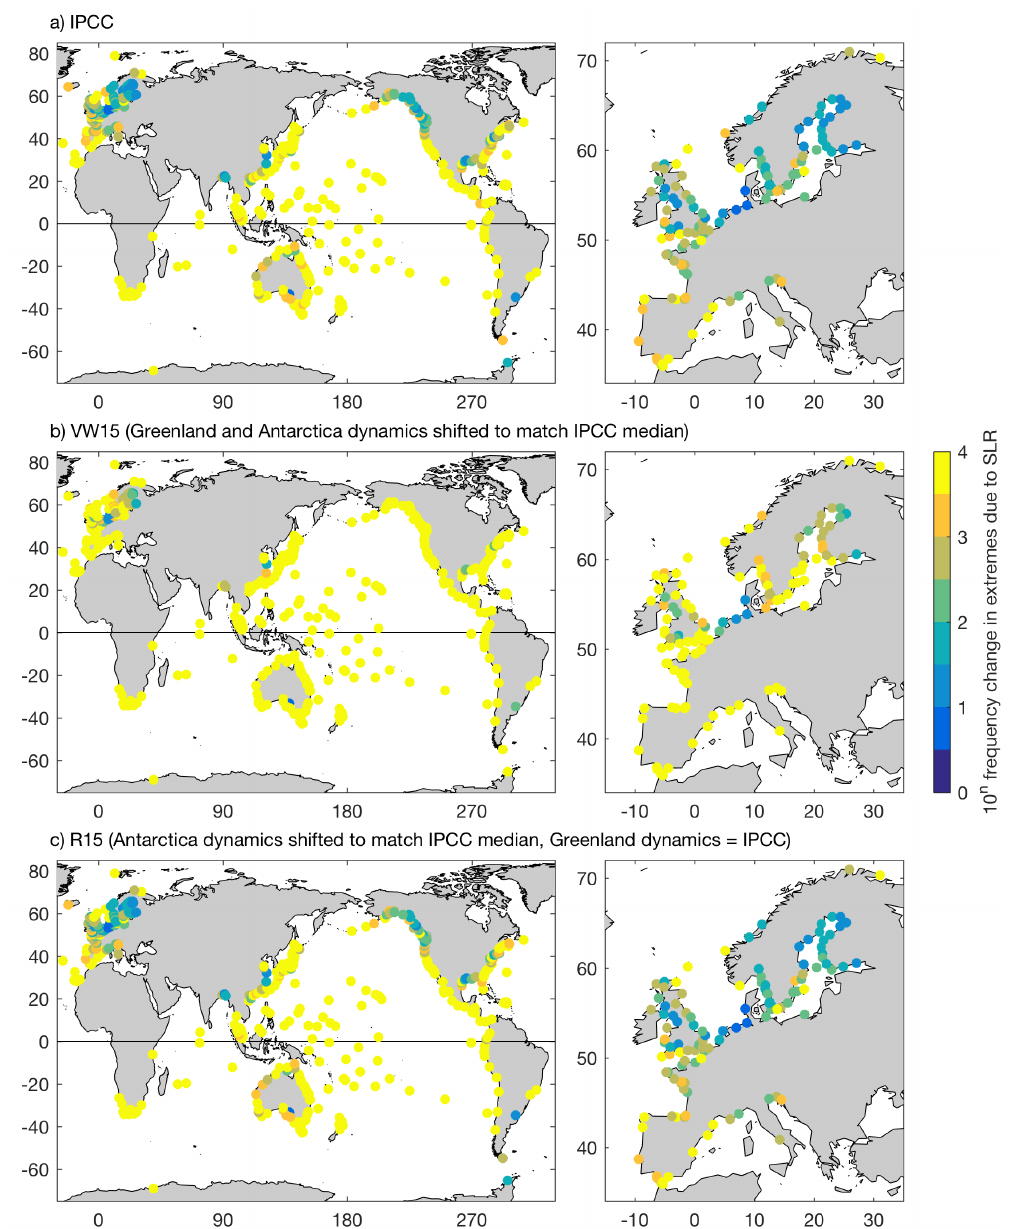
Figure 9. Ratio of the change in the frequency of extreme events (2100 vs. 2010) if allowances are not applied, based on the ( a ) IPCC ( b ) VW15 and ( c ) R15 sea-level change scenario. Note the logarithmic scale. A limit of 10 4 has been imposed, as frequency increases above this level mean that a coastal structure effectively would be lost if no allowance is